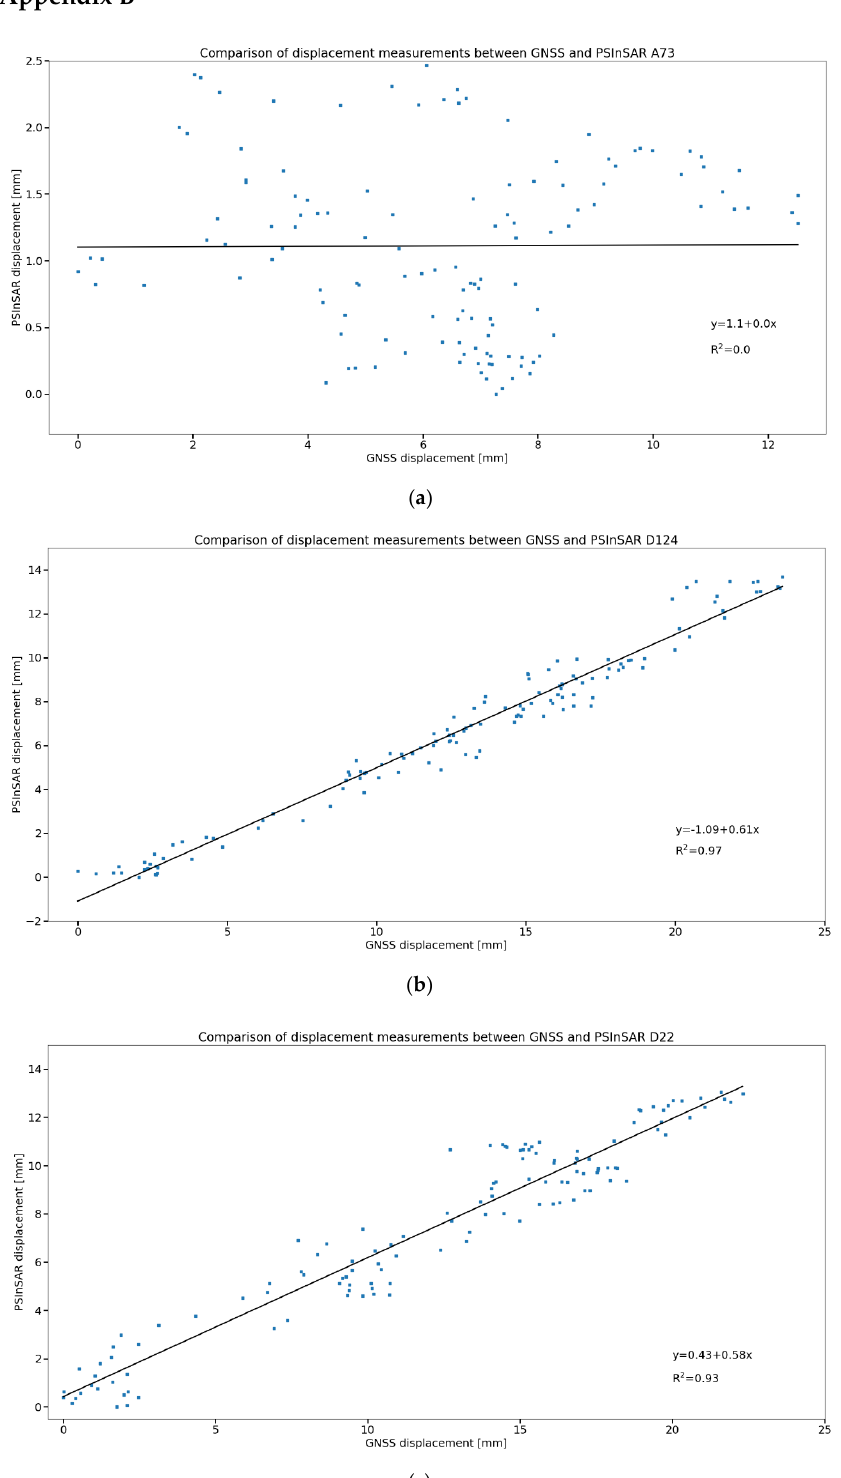
Figure A1. Star graphs showing the temporal/perpendicular baseline distribution between images for the track ( a ) A73, ( b ) D22, and ( c ) D124.